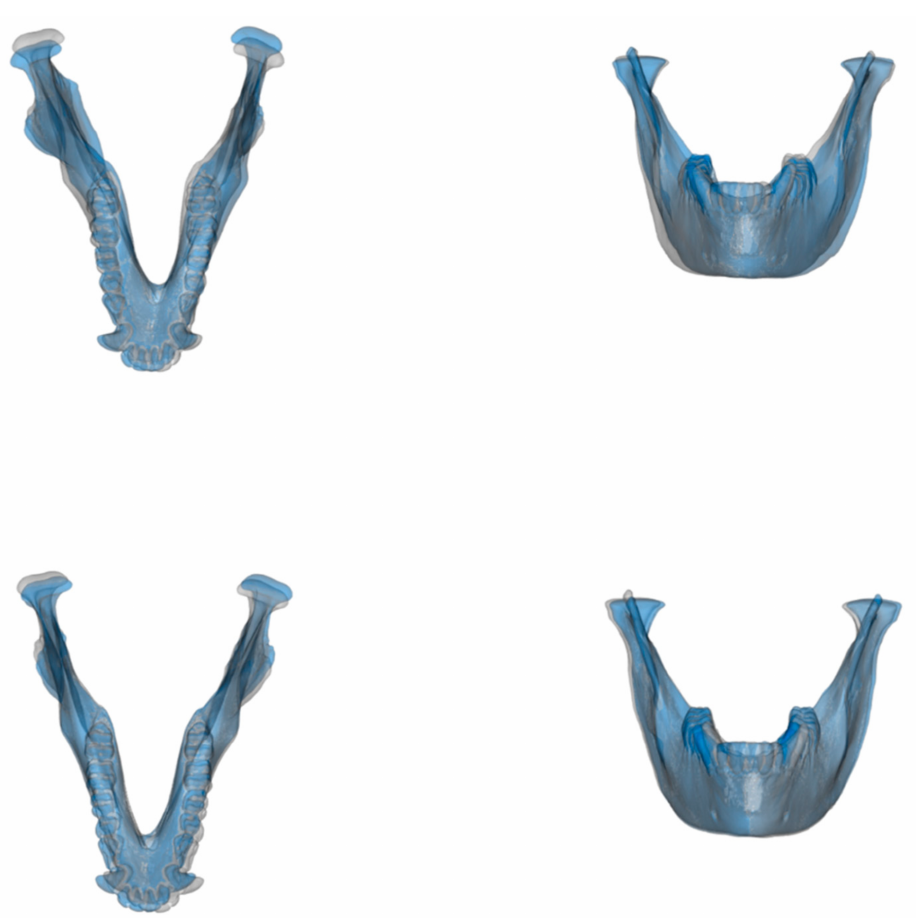
Figure 5. Surface warpings of the extremes of PC1 ( top ) and PC2 ( below ) of the asymmetric PCA. The grey surface indicates minimum (negative) values while the blue surface indicates maximum (positive) values along the PCA